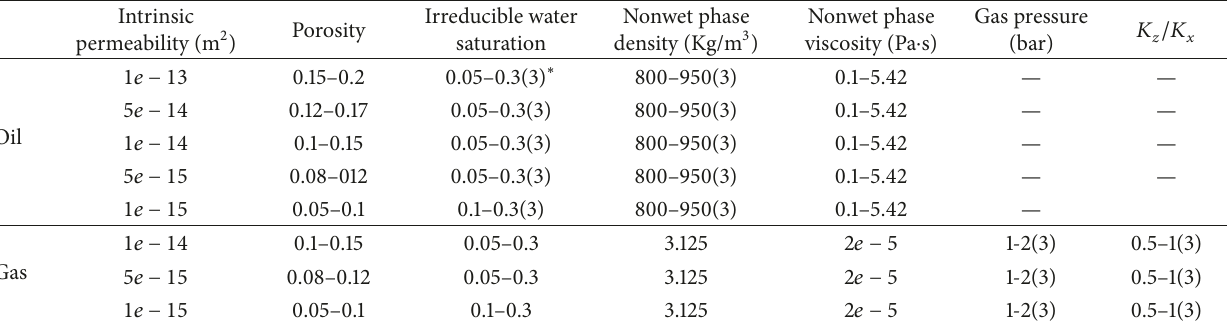
Table 1: Values and domain of the selected parameters.